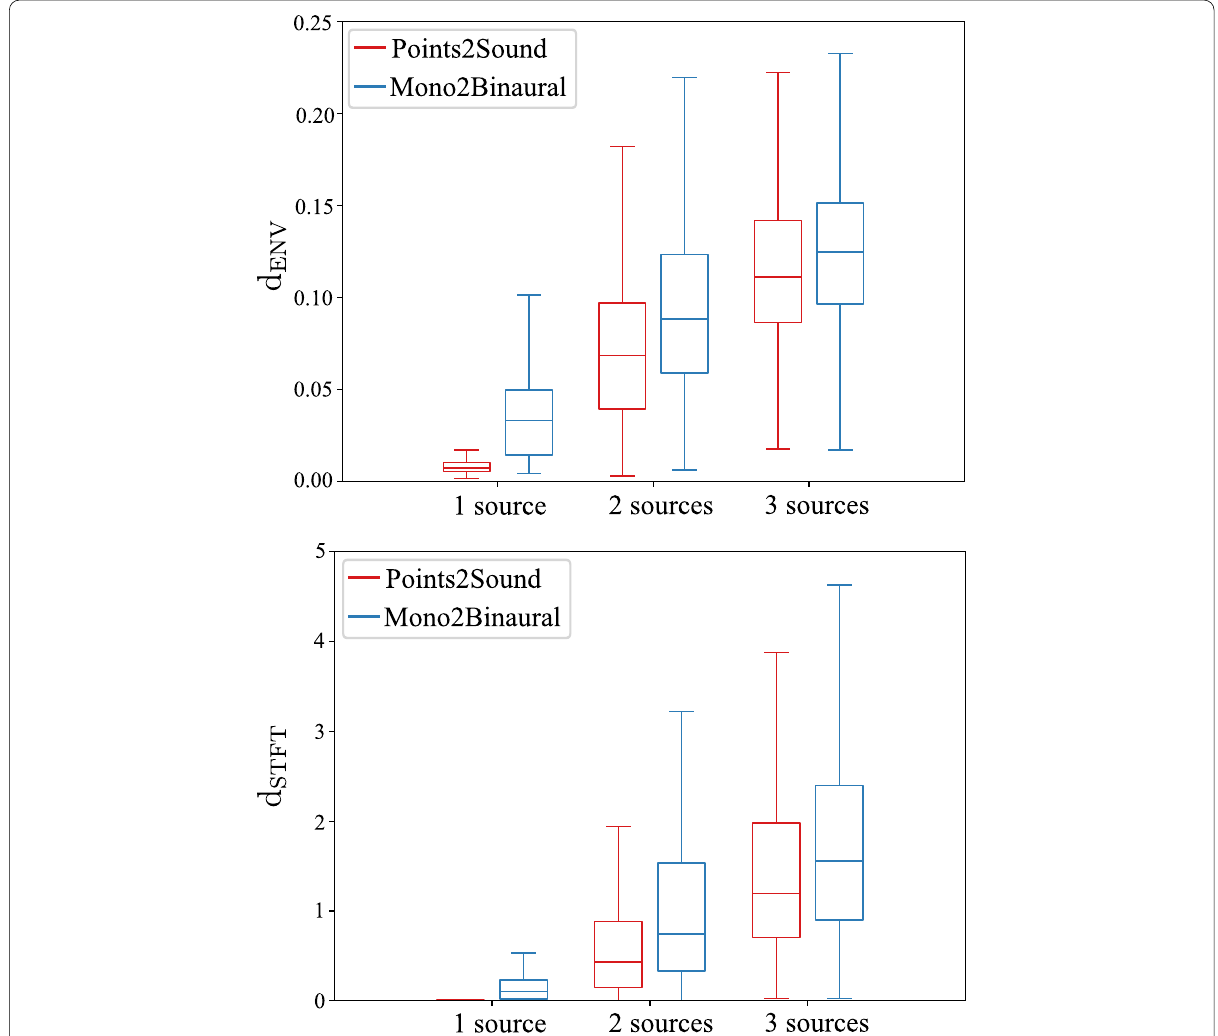
Fig. 5 Envelope Distance ( d ENV ) and STFT Distance ( d STFT ) of Points2Sound using L full loss function and Mono2Binaural for different numbers of sources in the 3D scene. The results are reported using rgb-depth point cloud features. For each number of sources, the box extension shows the first and third quartile of the data with a line at the median. The whiskers extending from the box show the range of the data